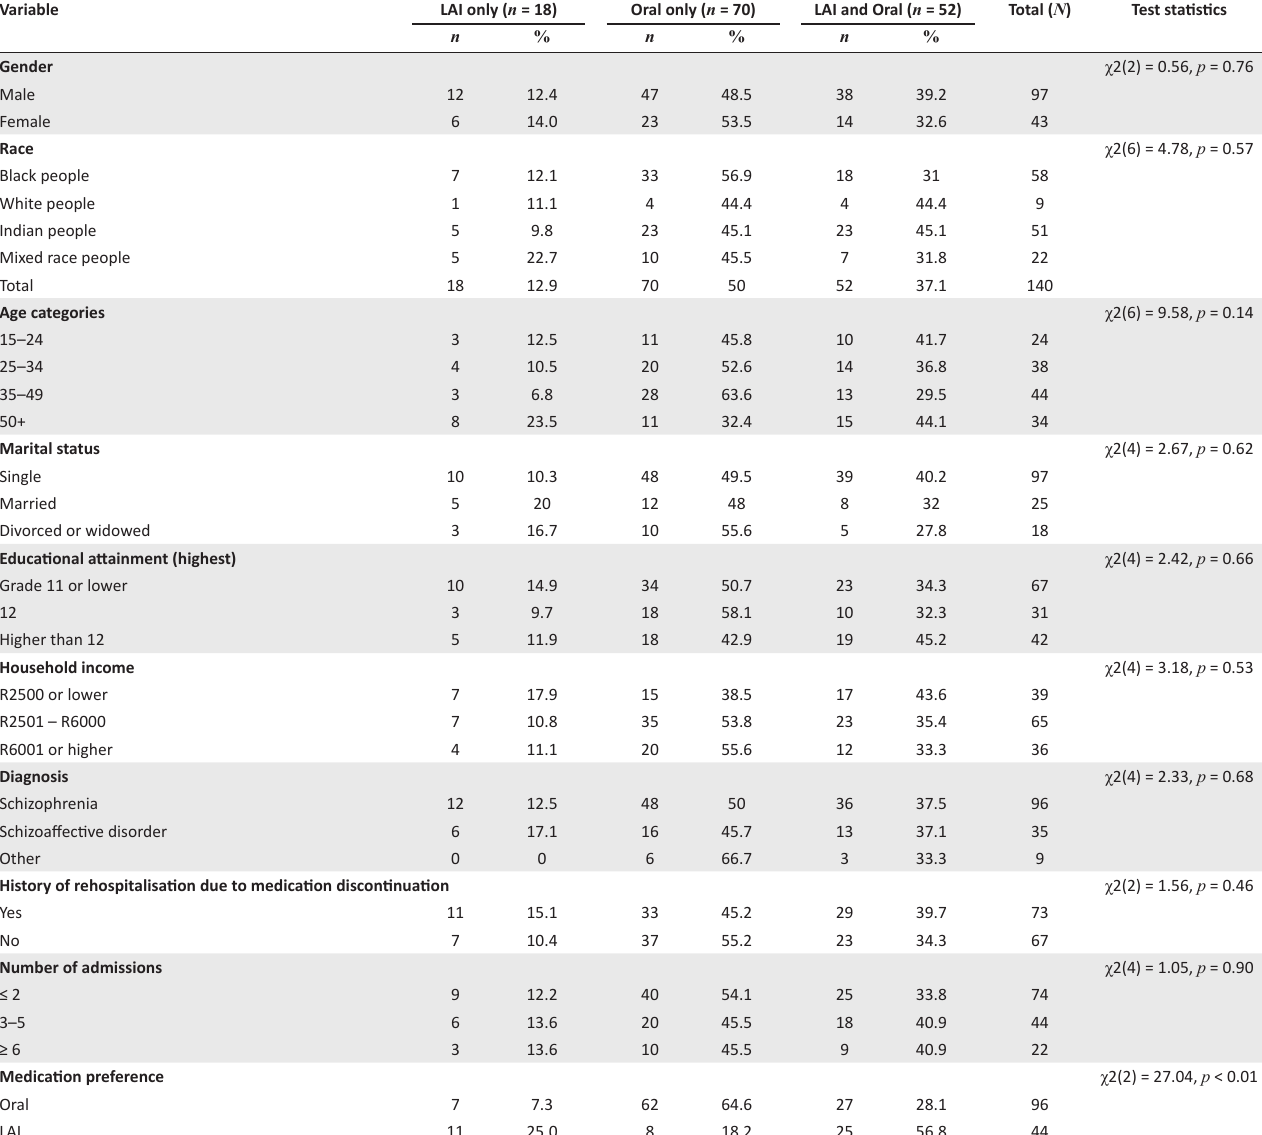
TABLE 2: Sociodemographic and clinical profiles of participants stratified by type of antipsychotic medication formulation. Variable LAI only ( n = 18) Oral only ( n = 70) LAI and Oral ( n = 52)